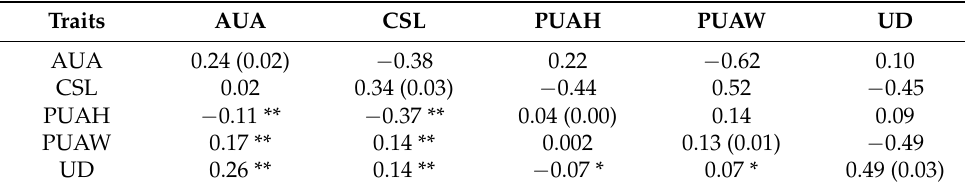
Table 2. Genotyping (upper diagonal) and phenotyping (lower diagonal) correlations, and the heritability (grey, diagonal) for udder traits in Holstein cattle.